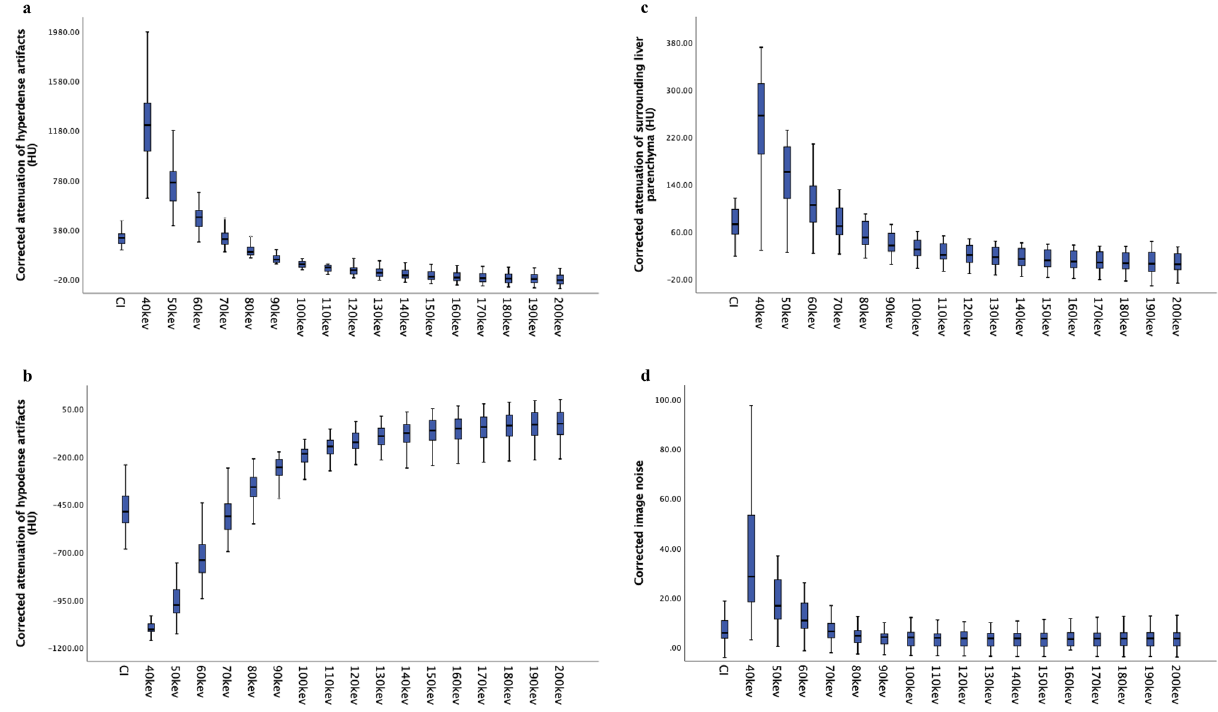
Figure 2. Box-plot diagram showing corrected attenuation of hyperdense artifacts ( a ), hypodense artifacts ( b ) and the surrounding liver parenchyma impaired by artifacts ( c ) and corrected image noise ( d ) on conventional images (CI) and virtual monoenergetic images (VMIs) at 40–200 keV. VMIs at high energy levels can significantly reduce corrected attenuation but cannot reduce corrected image noise compared to